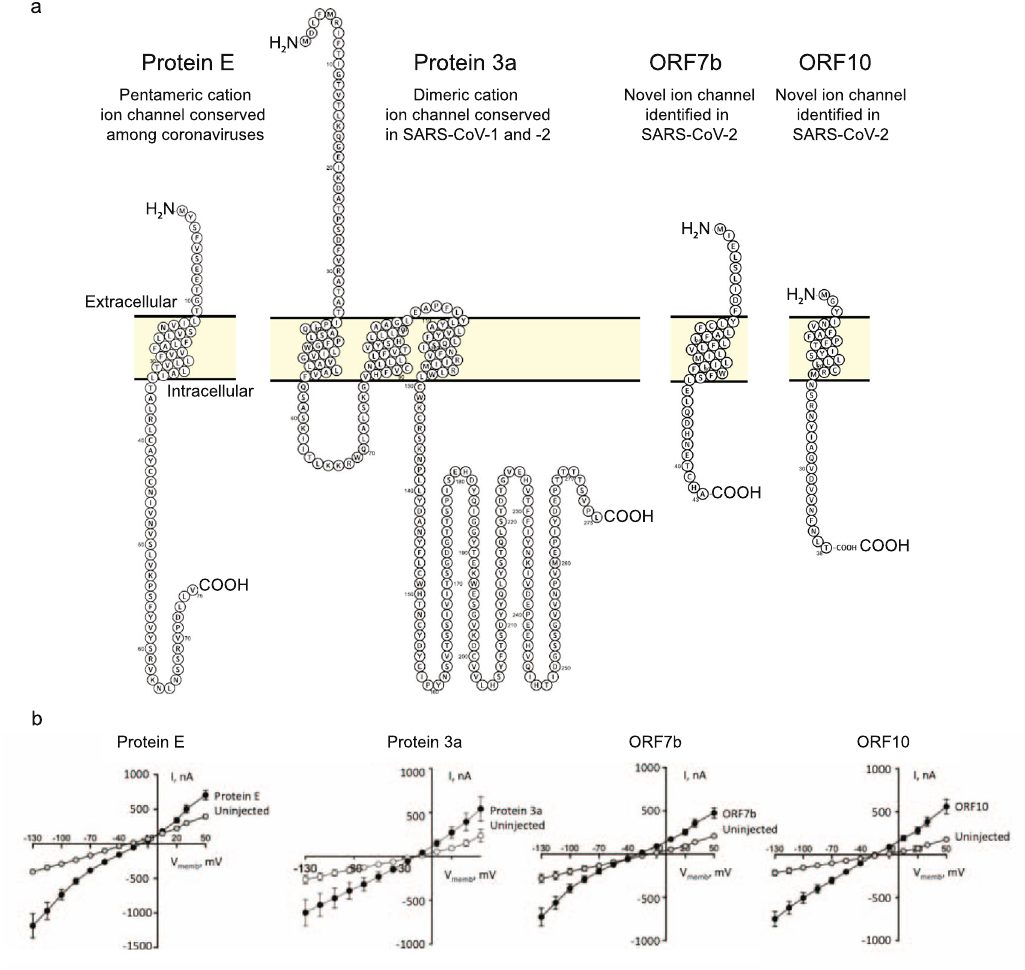
Fig. 4 Overview of four viroporins encoded by SARS-CoV-2: Protein E, Protein 3a, ORF7b, and ORF10. a Overall structure and ion channel function of known (Proteins E and 3a) and novel viroporins identi fi ed in the current study (ORF7b and ORF10). The membrane topology was predicted by TMHMM2 67 and displayed using Protter 68 . b Ion channel activity mediated by Protein E, Protein 3a, ORF7b, and ORF10 electrophysiologically monitored in X. laevis oocytes, here shown as summarized and averaged I/V relations in oocytes expressing the viroporins compared to control (uninjected) oocytes of n = 3 biologically independent experiments.